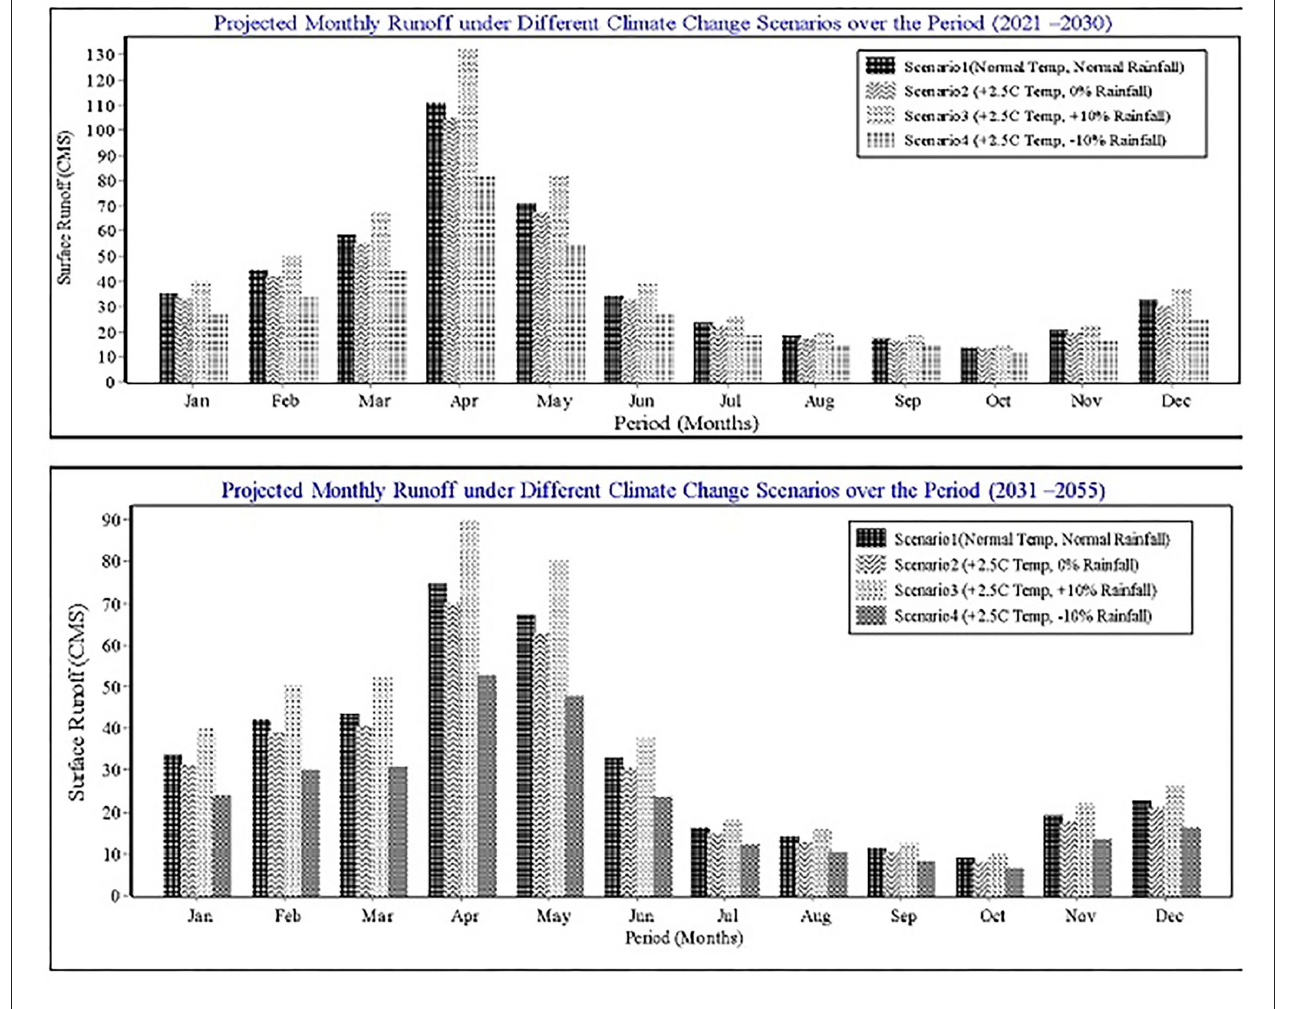
FIGURE 7 | Projected monthly synthetic scenarios over the period